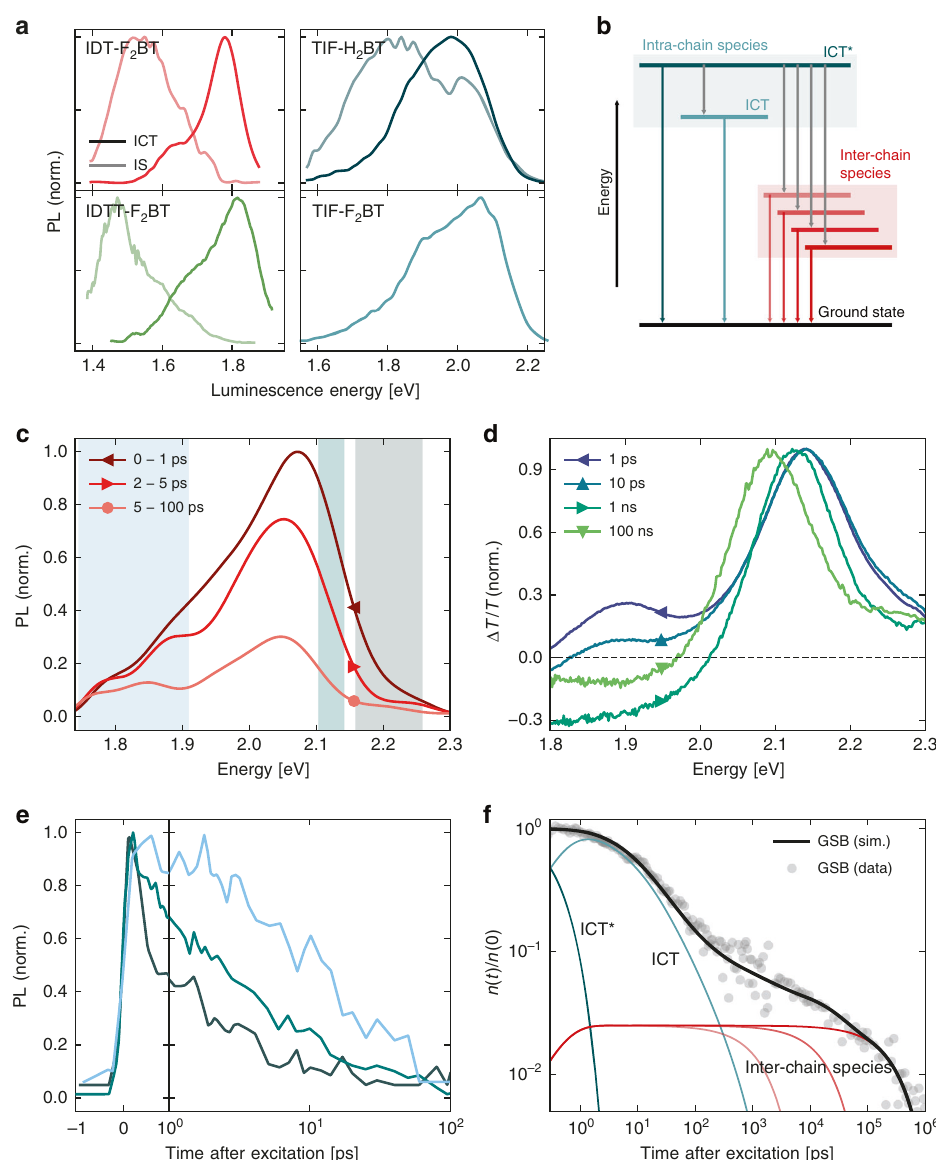
Fig. 3 Transient optical characterisation. a PL spectra of the prompt and delayed emissive species extracted from the genetic algorithm. b Energy level diagram summarising the exciton dynamics. For TIF-H 2 BT: ( c ) ultrafast PL spectra normalised to the maximum of the fi rst time-slice shown; ( d ) normalised TA spectra for different time delays; ( e ) kinetics of the PL decay in the different energy bands shaded in ( a ); and ( f ) GSB with population fi ts normalised to the maximum signal together with a fi t of the contributions from different excited state species according to the kinetic